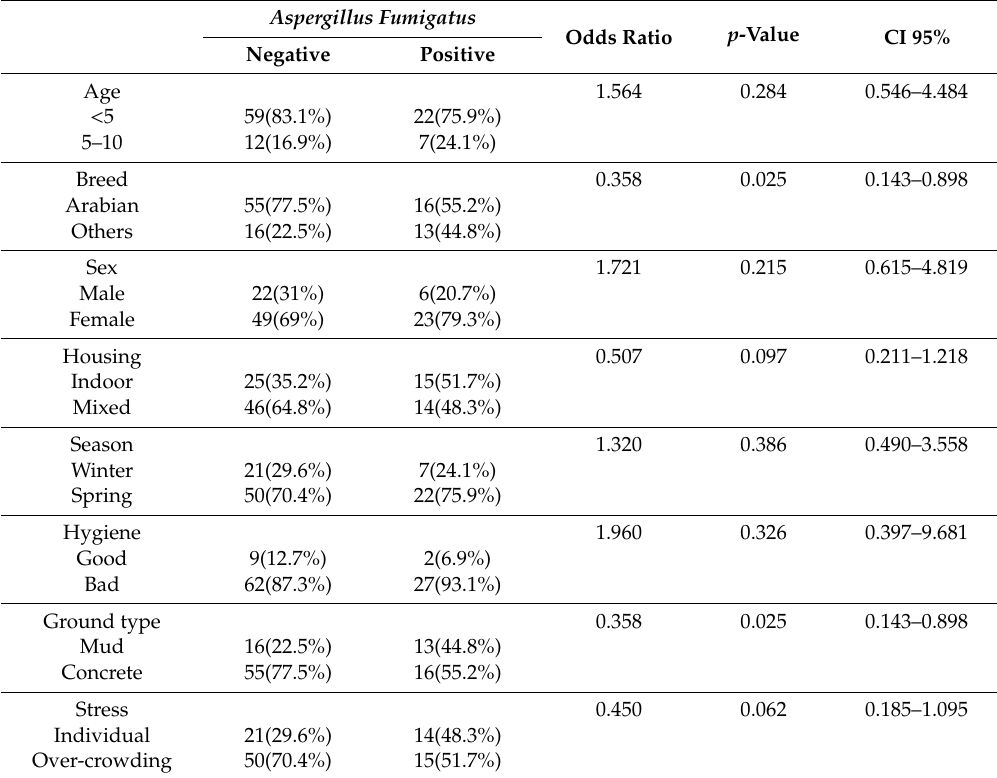
Table 4. Risk factors of Aspergillus fumigatus.